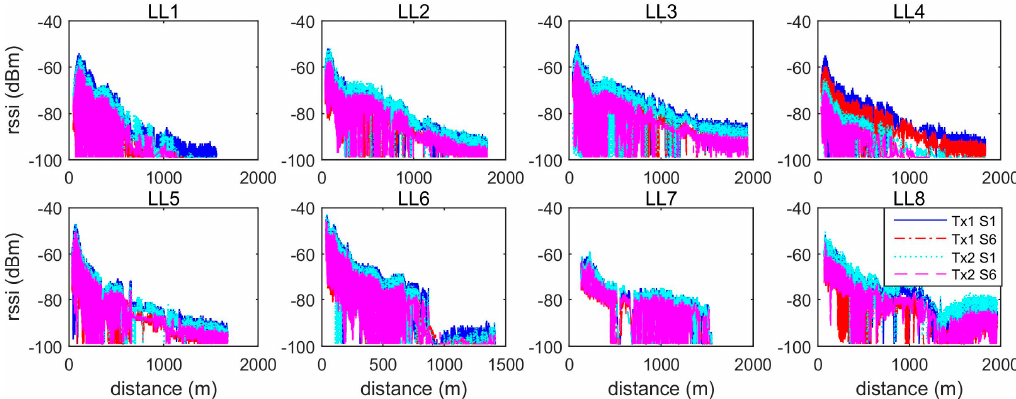
Figure 8. The Received Signal Strength Indicator (rssi) change (dBm) with respect to distance.